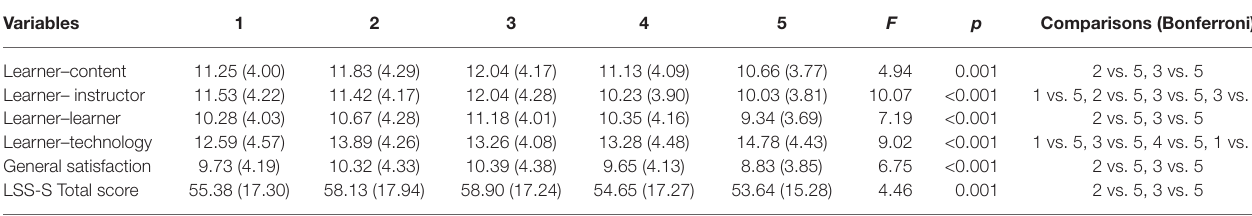
TABLE 7 | Means ( M ), standard deviation ( SD ) in parentheses, F statistics, probability, and mean comparisons by area of knowledge. Variables Comparisons